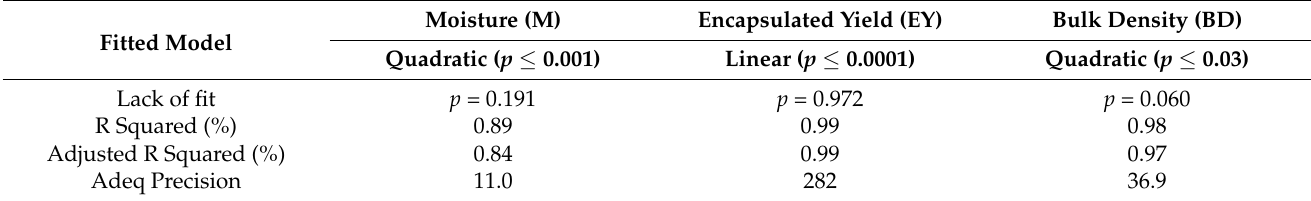
Table 3. Regression models for physical parameters of onion